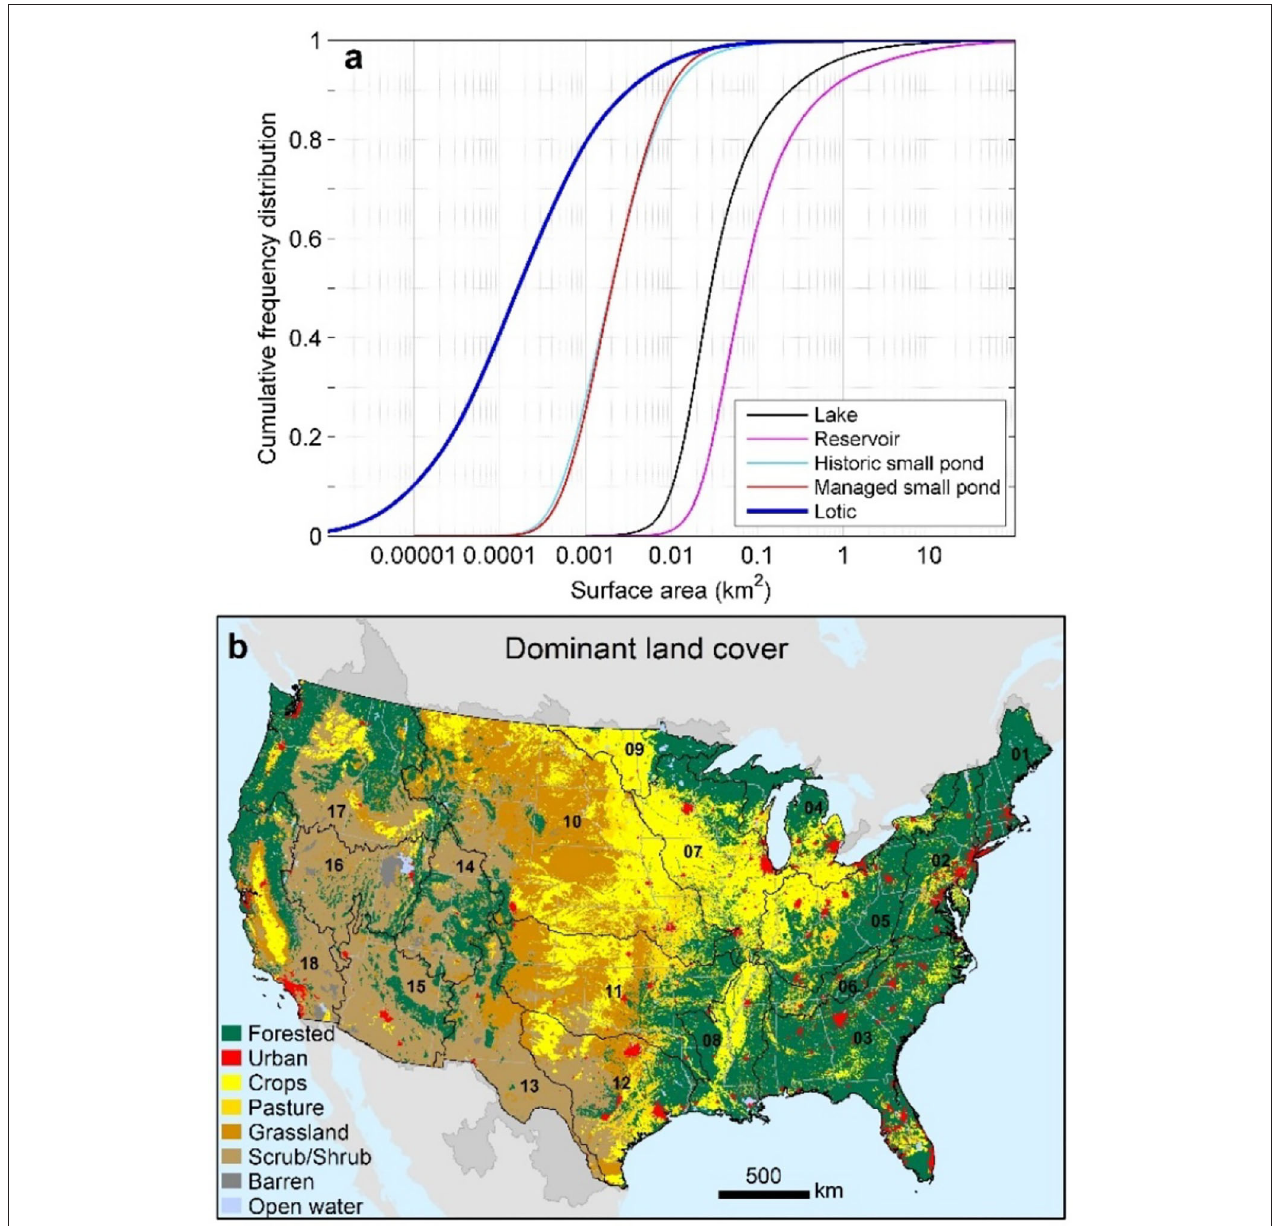
FIGURE 2 | Size distribution of river corridor features for over 90,000 lakes, 34,000 reservoirs, 1.7 million small ponds with over 800,000 managed, and 10 million kilometers of streams and rivers in the CONUS (a) and major land use and land cover in the CONUS and within HUC-2 river basins designated by black numbers and associated basin boundaries (b)